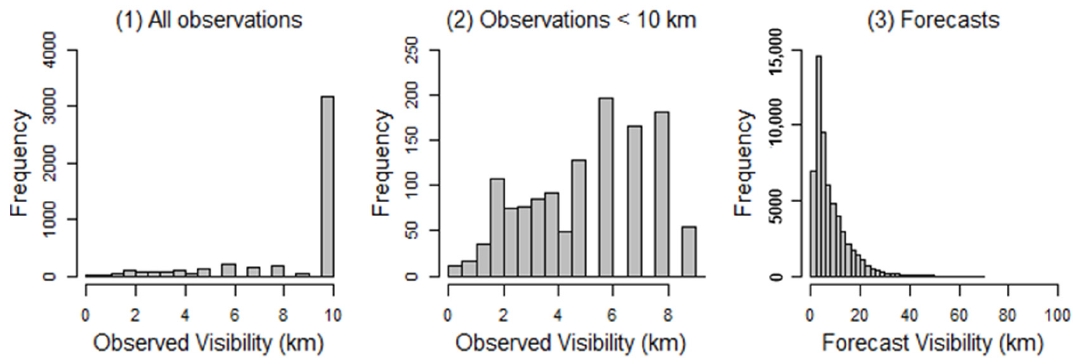
Figure 1. Histograms of visibility observations and forecasts for Station 110: ( 1 ) all observations, ( 2 ) observations < 10 km, and ( 3 ) ensemble forecasts.